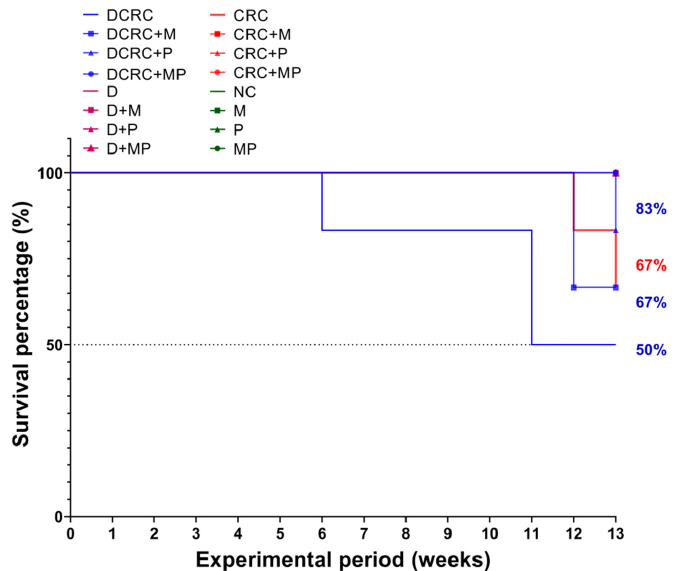
Figure 4. Kaplan–Meier survival curves of animals in the different groups. Diabetic animals with